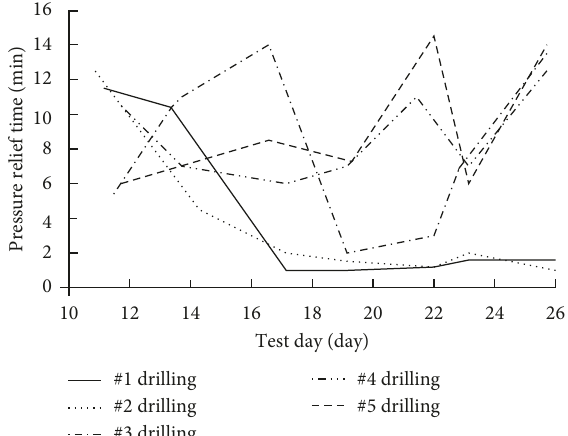
Figure 8: Variation curve of decompression time at different holes of the #11 working face versus the advancing distance of the working face.